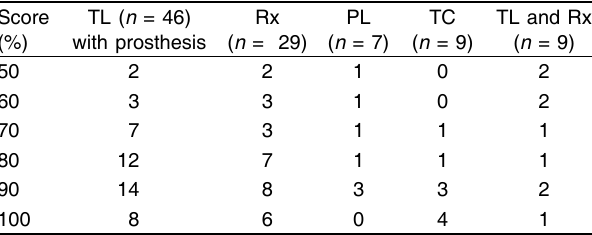
Table 3 Results of the Karnofsky Performance Status Scale [13]